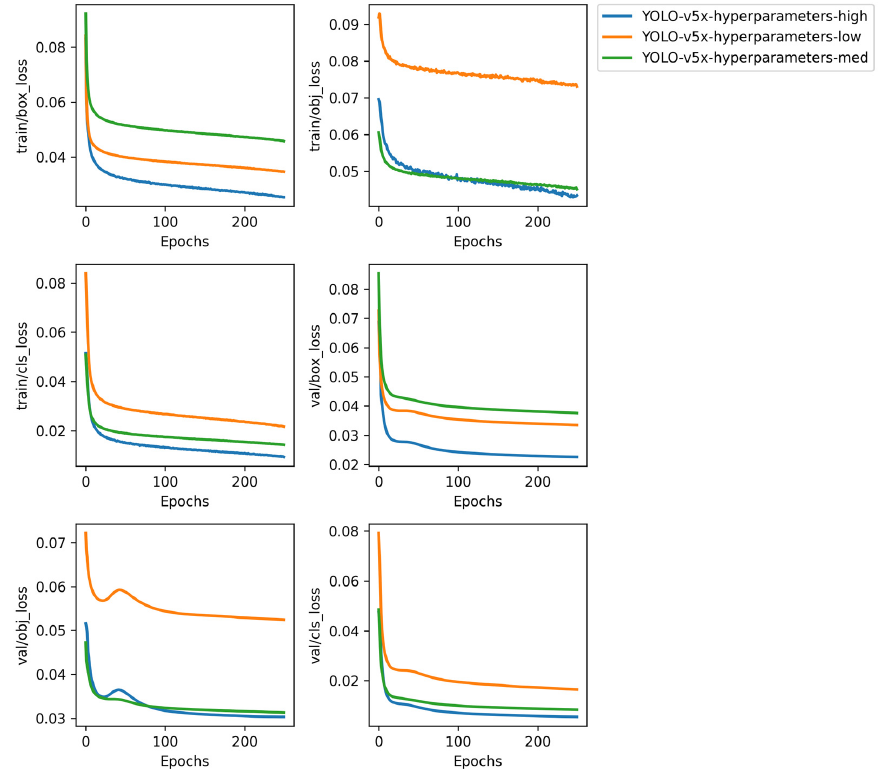
Figure 13. Training and validation loss functions of the proposed VPP framework over 250 epochs. ization strategies: hyp.scratch-low, hyp.scratch-med, and